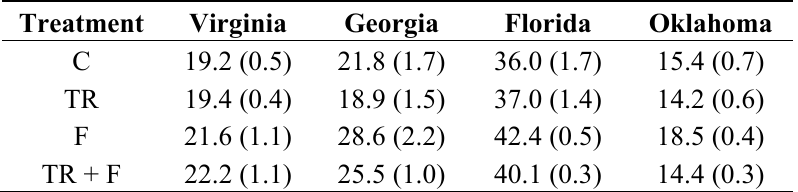
Figure 4. Stand volume measured before treatment initiation and following two growing seasons. Table 6. Periodic annual increment in stem volume outside-bark after 2 years (m 3 ·ha − 1 ·year − 1 ) for throughfall reduction (TR) and fertilization (F) treatment ( n = 4). Numbers in parentheses are standard